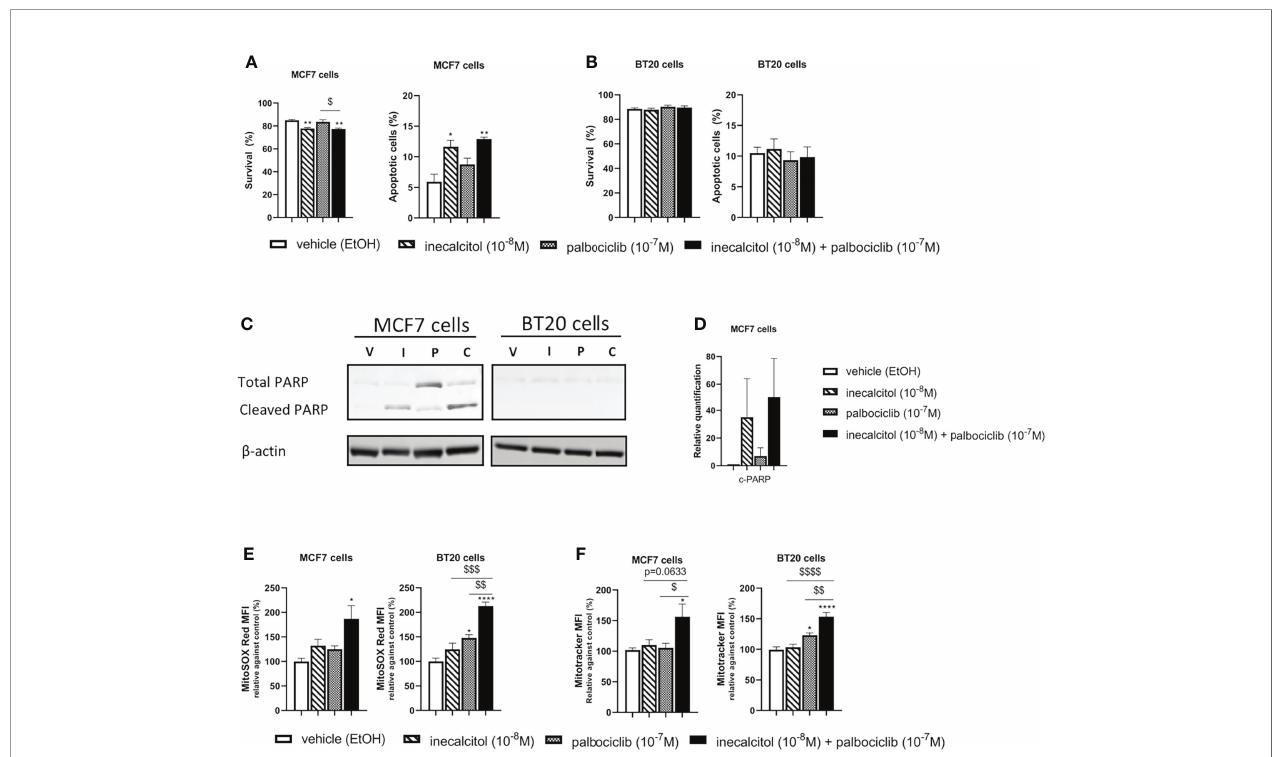
FIGURE 5 | Effect of inecalcitol and/or palbociclib treatment on apoptosis and mitochondrial homeostasis (A) Cell survival and apoptosis were determined by AnnexinV-PI FACS analysis in MCF7 cells after treatment with vehicle (EtOH, 72 h), inecalcitol (10 -8 M, 72 h), palbociclib (10 -7 M, 72 h) or the combination of both (72 h) (n=3 performed in duplicate). Data shown as mean ± SEM. (B) Cell survival and apoptosis were determined by AnnexinV-PI FACS analysis in BT20 cells after treatment with vehicle (EtOH, 72 h), inecalcitol (10 -8 M, 72 h), palbociclib (10 -7 M, 72 h) or the combination of both (72 h) (n=3 performed in duplicate). Data shown as mean ± SEM. (C) PARP cleavage (89 kDa) in MCF7 and BT20 cells after treatment with vehicle (EtOH, 72 h), inecalcitol (10 -8 M, 72 h), palbociclib (10 -7 M, 72 h) or the combination of both (72 h). b -actin (42 kDa) was used as loading control. One representative blot is shown. (D) Relative quanti fi cation of cleaved PARP in MCF7 cells after 72 h of treatment (n=3). V = vehicle (EtOH), I = inecacitol (10 -8 M), P = palbociclib (10 -7 M) and C = combination of inecalcitol (10 -8 M) and palbociclib (10 -7 M). Data shown as mean ± SD. (E) Mitochondrial ROS levels were determined in MCF7 and BT20 cells after treatment with vehicle (EtOH, 72 h), inecalcitol (10 -8 M, 72 h), palbociclib (10 -7 M, 72 h) or the combination of both (72 h) (n=3 performed in duplicate). Data were expressed relative to vehicle (%) and shown as mean ± SEM. (F) Mitotracker Deep Red was analyzed in MCF7 and BT20 cells after treatment with vehicle (EtOH, 72h), inecalcitol (10 -8 M, 72 h), palbociclib (10 -7 M, 72 h) or the combination of both (72 h) (n=5/6 performed in duplicate). Data were expressed relative to vehicle (%) and shown as mean ± SEM. *p ≤ 0.05; **p ≤ 0.01; ****p ≤ 0.0001 compared to vehicle; $ p ≤ 0.05; $$ p ≤ 0.01; $$$ p ≤ 0.001; $$$$ p ≤ 0.0001 compared to inecalcitol or palbociclib monotherapy (one-way ANOVA, Sidak ’ s multiple comparison